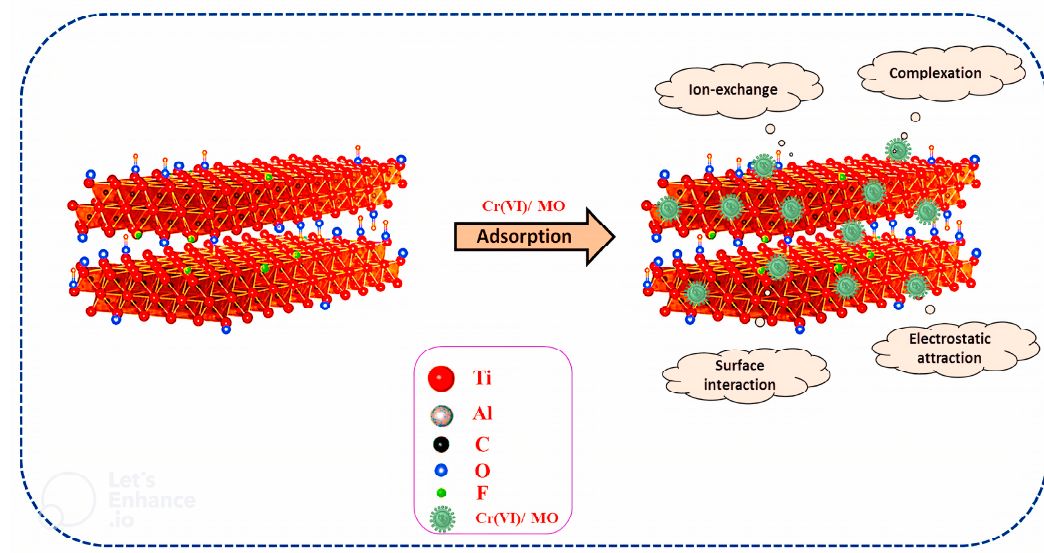
Figure 4. Degradation of Cr(VI) and MO by MXenes [136].